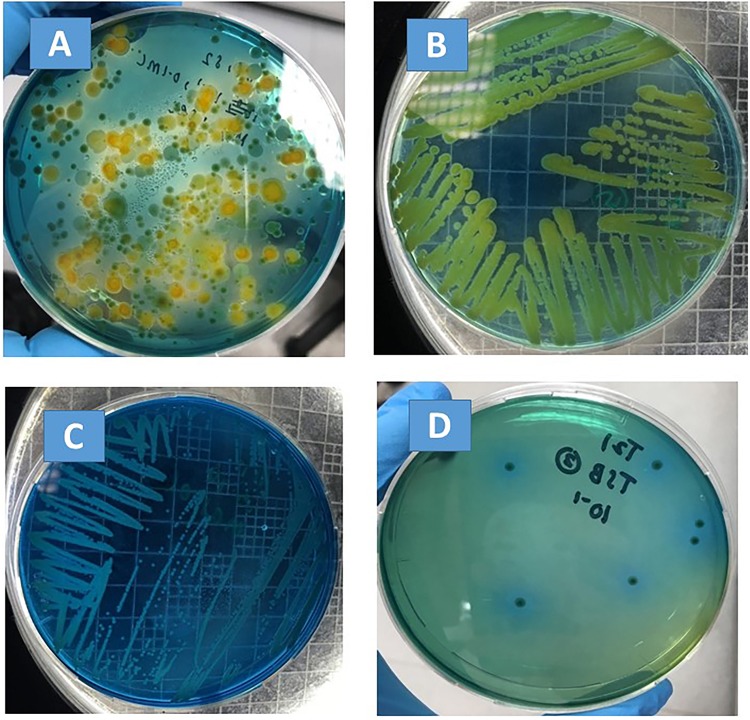
Bacterial morphology on VIA plates. (A) Plated with basil extract; (B) sub-culture of a green colony from (A), which was confirmed to be P. fluorescens by API 20NE; (C) sub-culture of a green colony from (A), which was confirmed to be S. maltophilia by API 20NE; (D) plated with filter-sterilized basil juice inoculated with S. maltophilia.